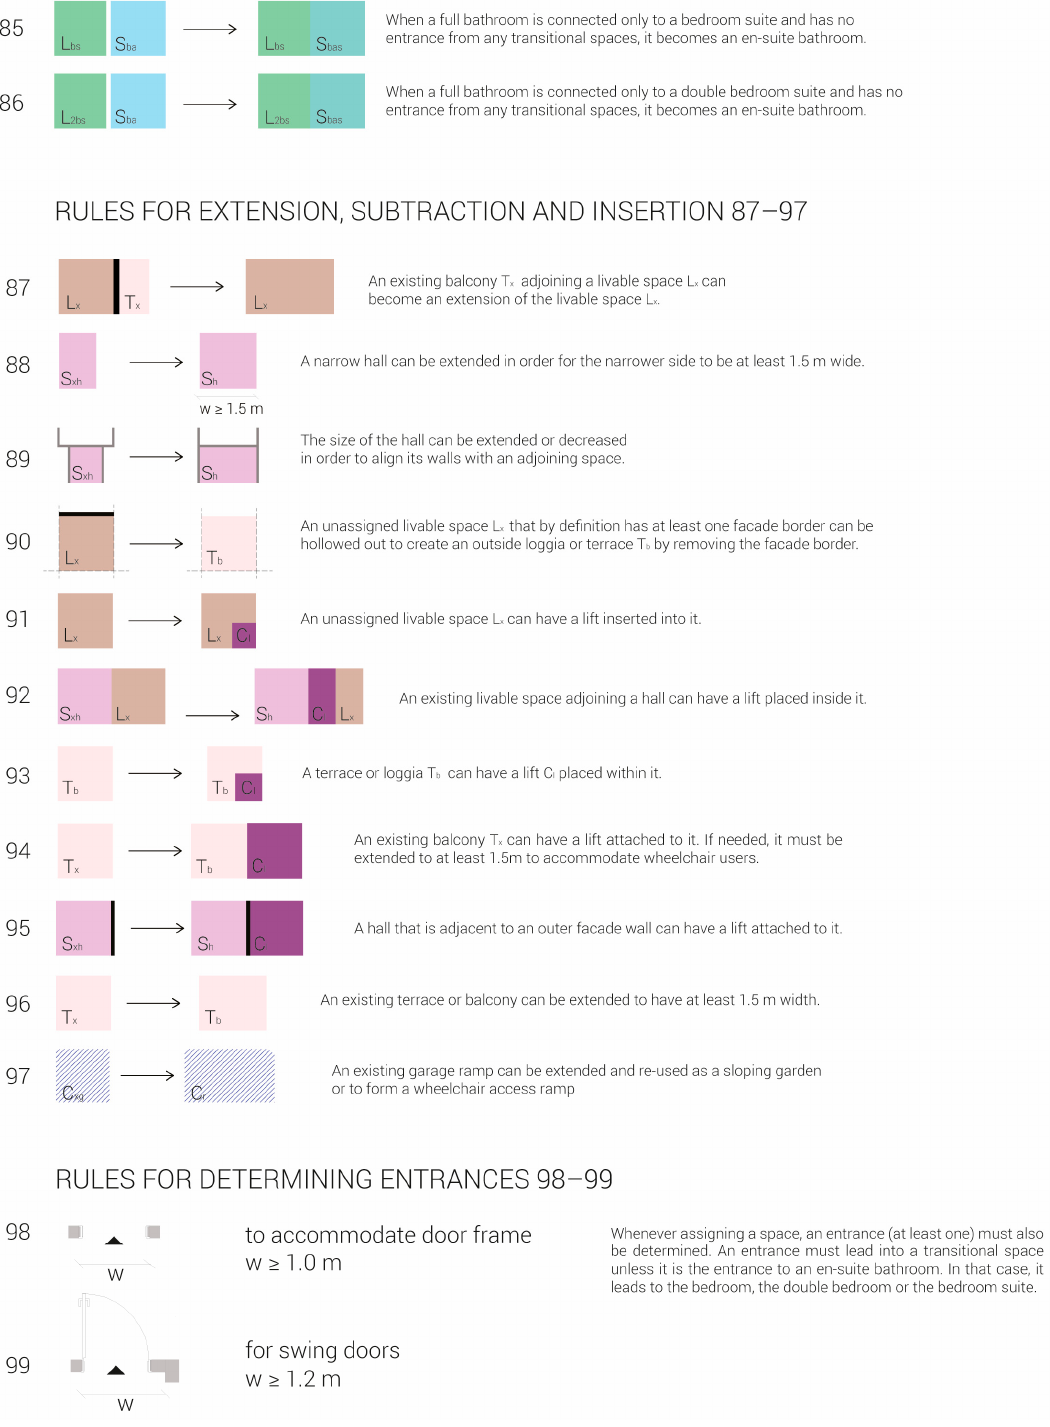
Figure 14. Transformation rules 85–99 (Ana Bel č i č , 2022).